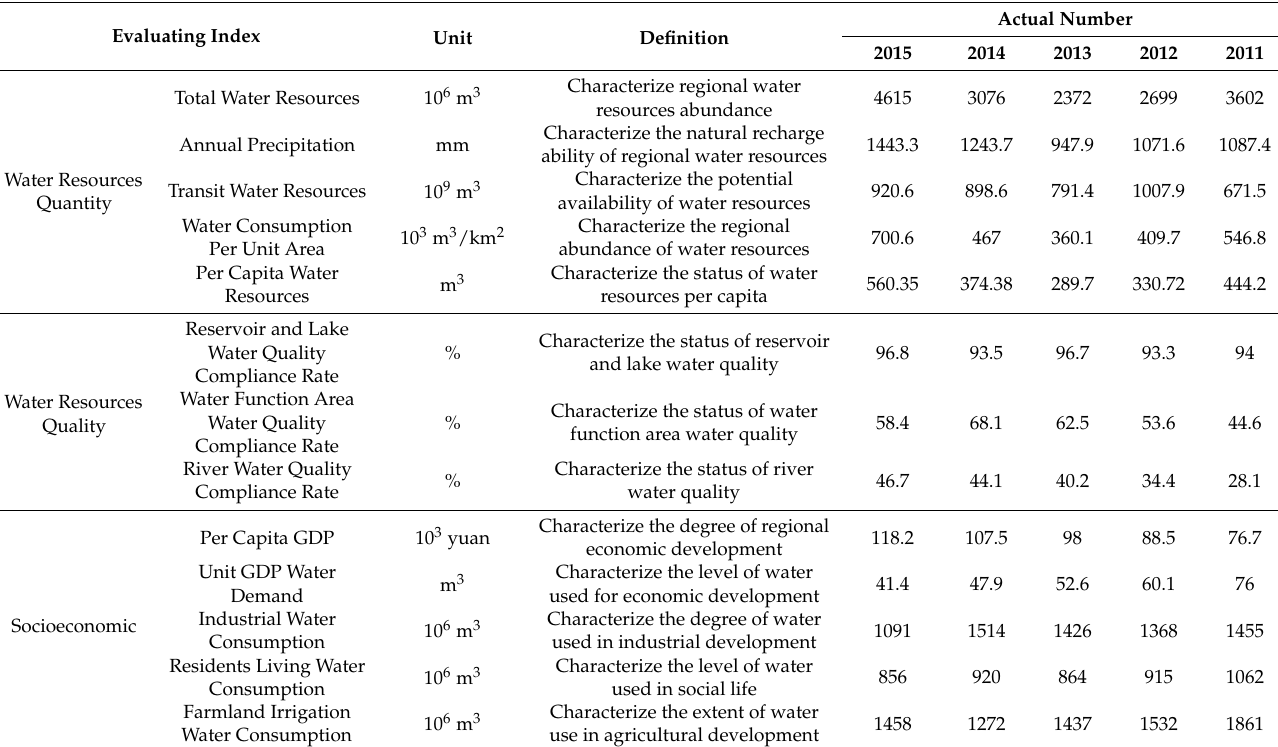
Table 1. Water resource value evaluation indices for